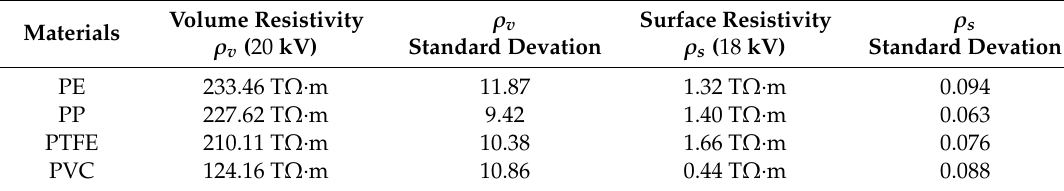
Table 2. Volume and surface resistivity of insulating